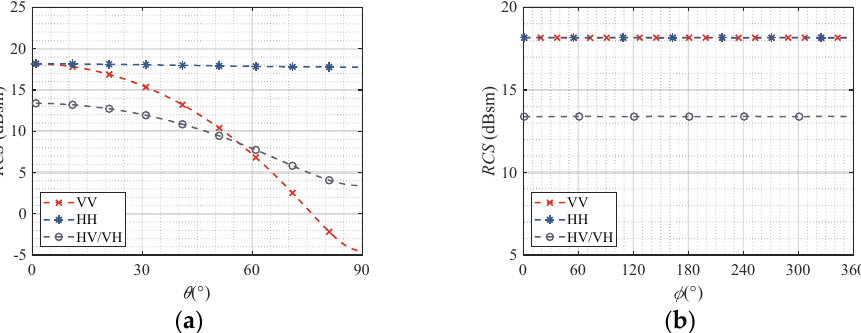
Figure 10. The angular distribution of the chaff cloud RCS with 500,000 elements for different polarizations. ( a ) ϕ = 0 ◦ , θ = 0 ◦ ∼ 90 ◦ ; ( b ) θ = 0 ◦ , ϕ = 0 ◦ ∼ 360 ◦